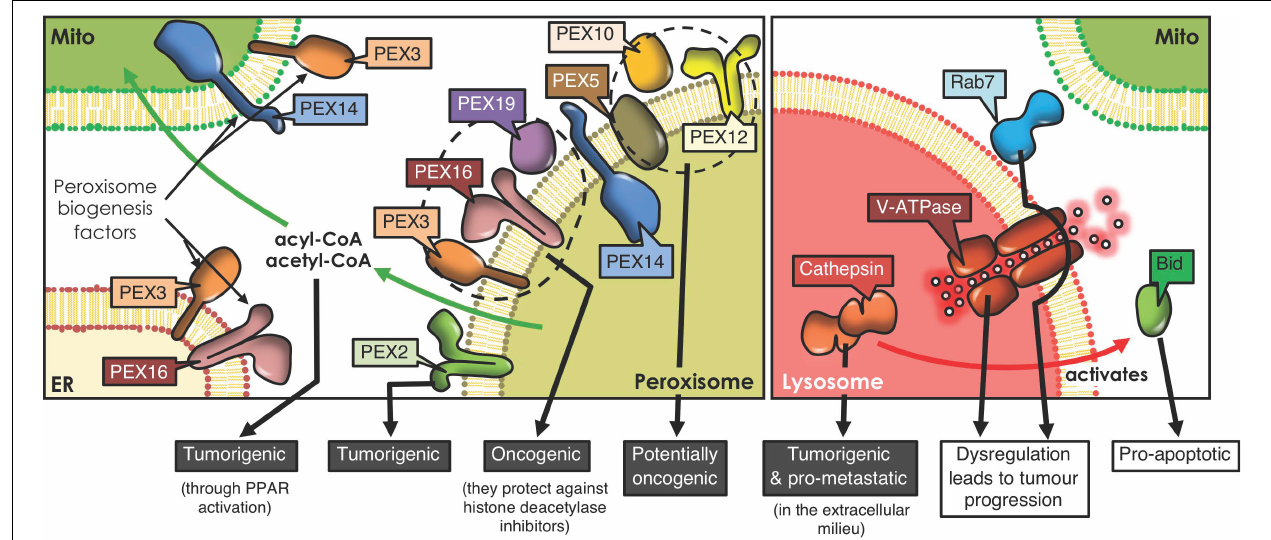
FIGURE 2 | Peroxisome and lysosome interactions and cancer development. Peroxisomes derive from ER and mitochondrial membranes, and the proteins involved in peroxisome biogenesis and their regulation reportedly have tumorigenic potential. Moreover, peroxisome-mitochondria metabolic coupling favors cell proliferation and tumorigenesis through fatty acid transfer. Lysosomes form contacts with mitochondria, orchestrated by proteins, such as Rab7. Lysosomes play an ambiguous role in cancer. For instance, cathepsins, the proteolytic lysosomal enzymes, promote tumorigenesis when released to the extracellular milieu, but trigger Bid-mediated apoptosis upon accessing the cytoplasm. Also, dysregulation of either V-ATPase, the complex that acidifies lysosomes, or Rab7, the GTPase that orchestrates mitochondria-lysosome contact sites, both promote tumor progression (PPAR, Peroxisome proliferator-activated